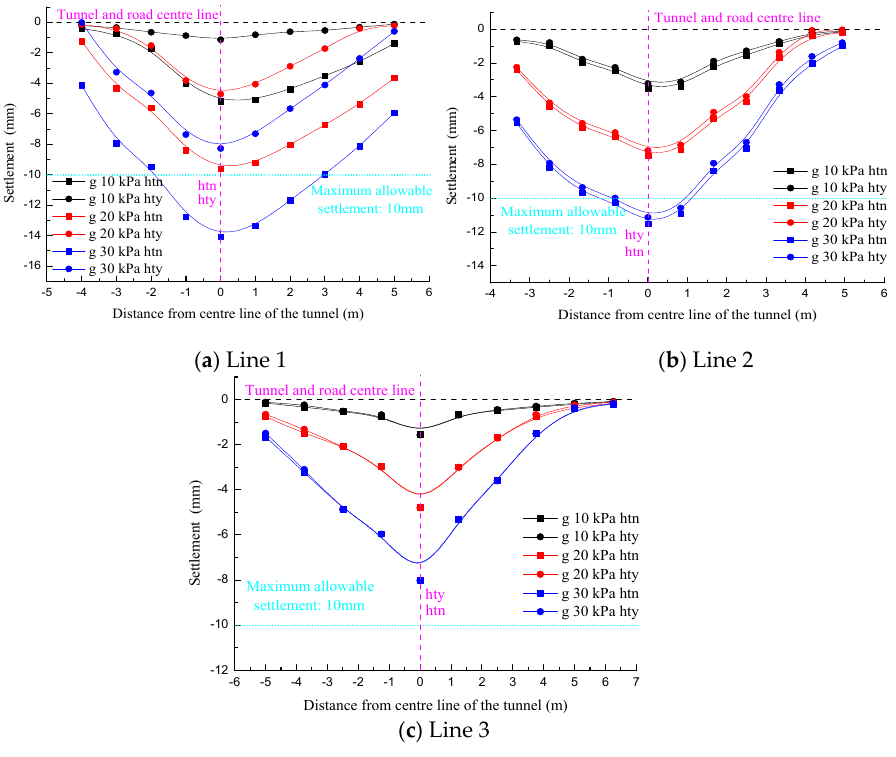
Figure 17. Longitudinal surface settlement of model G-G with D/W = 0.378. Appl. Sci. 2020 , 10 , x FOR PEER REVIEW